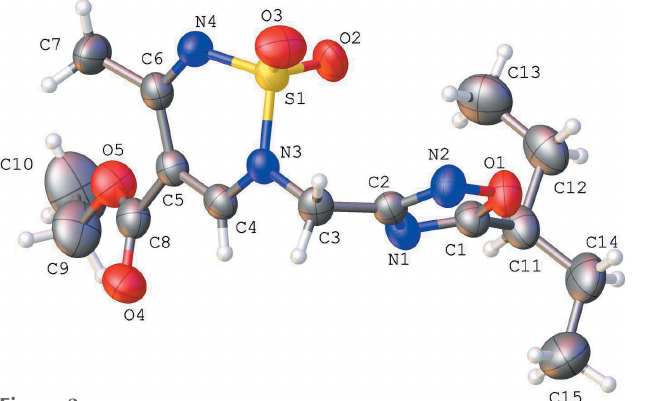
Figure 3 The molecular structure of compound 3 , with atom labelling. Displace- ment ellipsoids are drawn at the 50% probability level.